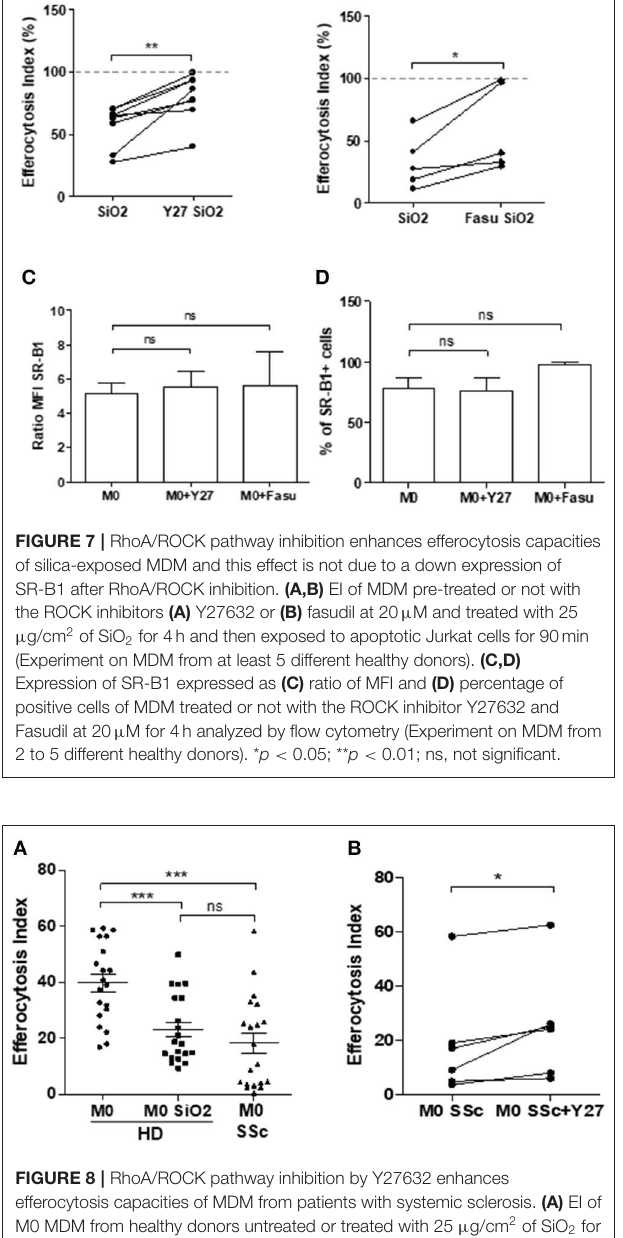
alveolar M 8 (40). The concentration of SiO 2 used in vivo (1.5 mg/mice), although lower than the concentrations used in mouse models of silicosis (2.5 to 10 mg/mice) (41–43), was able to induce granuloma formation (data not shown). We can thus hypothesize that the observed defect of efferocytosis at